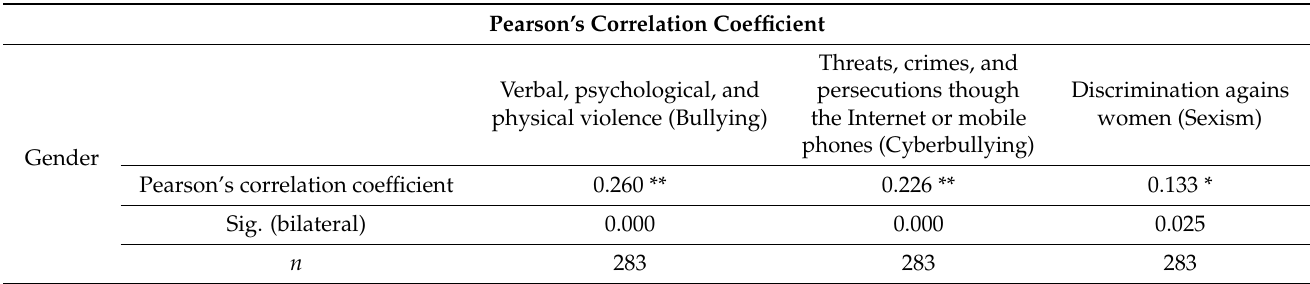
Table 6. Your opinion toward these social problems.